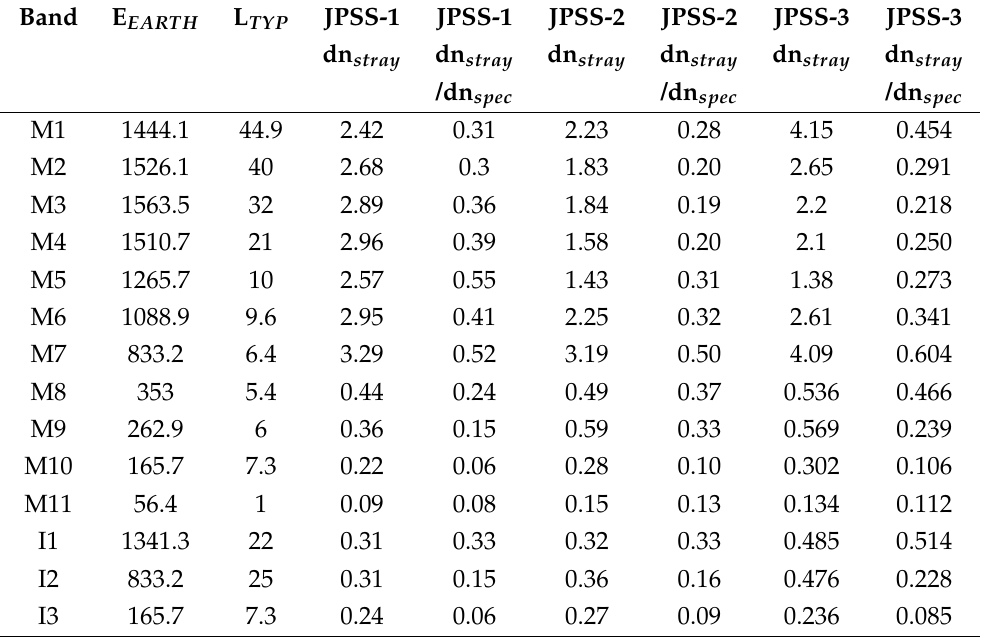
Table 10. JPSS-3 VIIRS stray light performance relative to the sensor specification